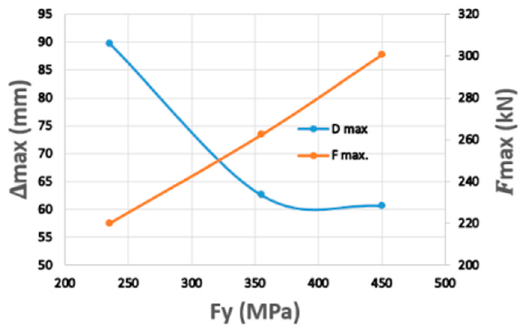
Figure 14. Effect of steel yield on the impact force and displacement.